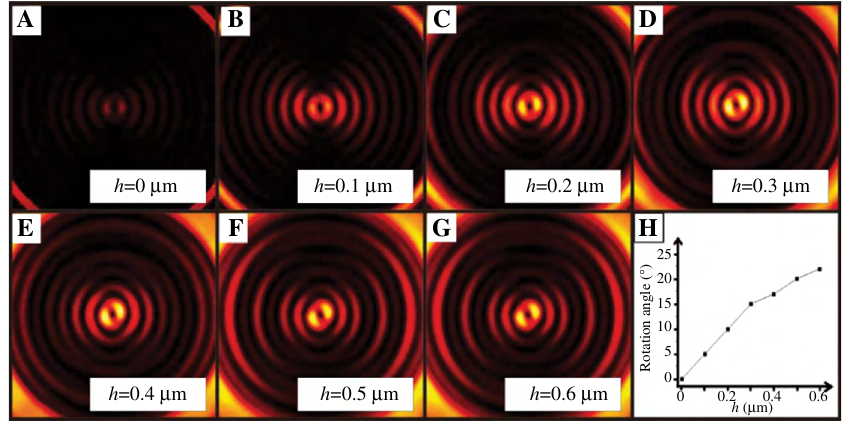
Figure 24 Intensity distribution of the optical field near the plasmonic antenna for l = +1 with different tip-sample distance h of (A) 0 μ m, (B) 0.1 μ m, (C) 0.2 μ m, (D) 0.3 μ m, (E) 0.4 μ m, (F) 0.5 μ m and (G) 0.6 μ m. (H) The rotation angle versus the tip-sample distance h . Adapted from Ref.